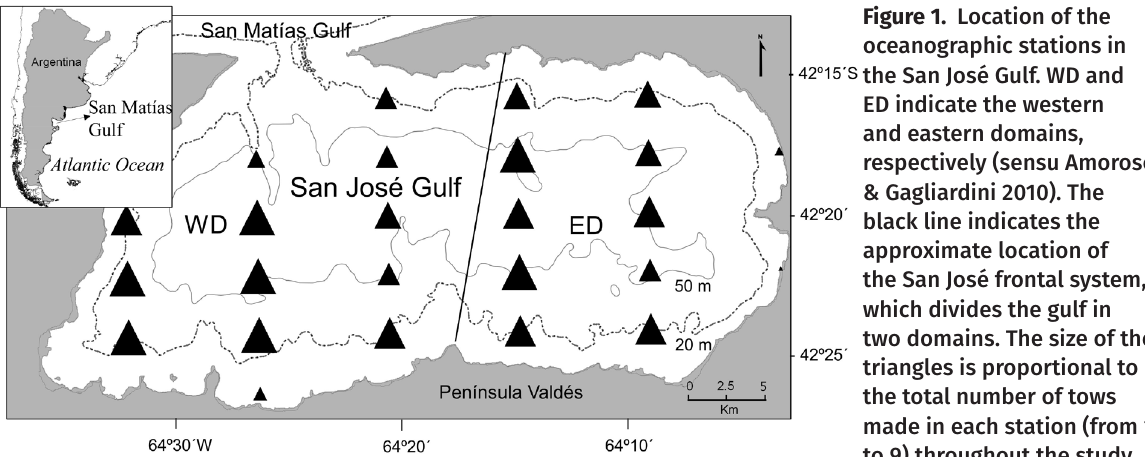
Figure 1. Location of the oceanographic stations in the San José Gulf. WD and ED indicate the western and eastern domains, respectively (sensu Amoroso & Gagliardini 2010). The black line indicates the approximate location of the San José frontal system, which divides the gulf in two domains. The size of the triangles is proportional to the total number of tows made in each station (from 1 to 9) throughout the